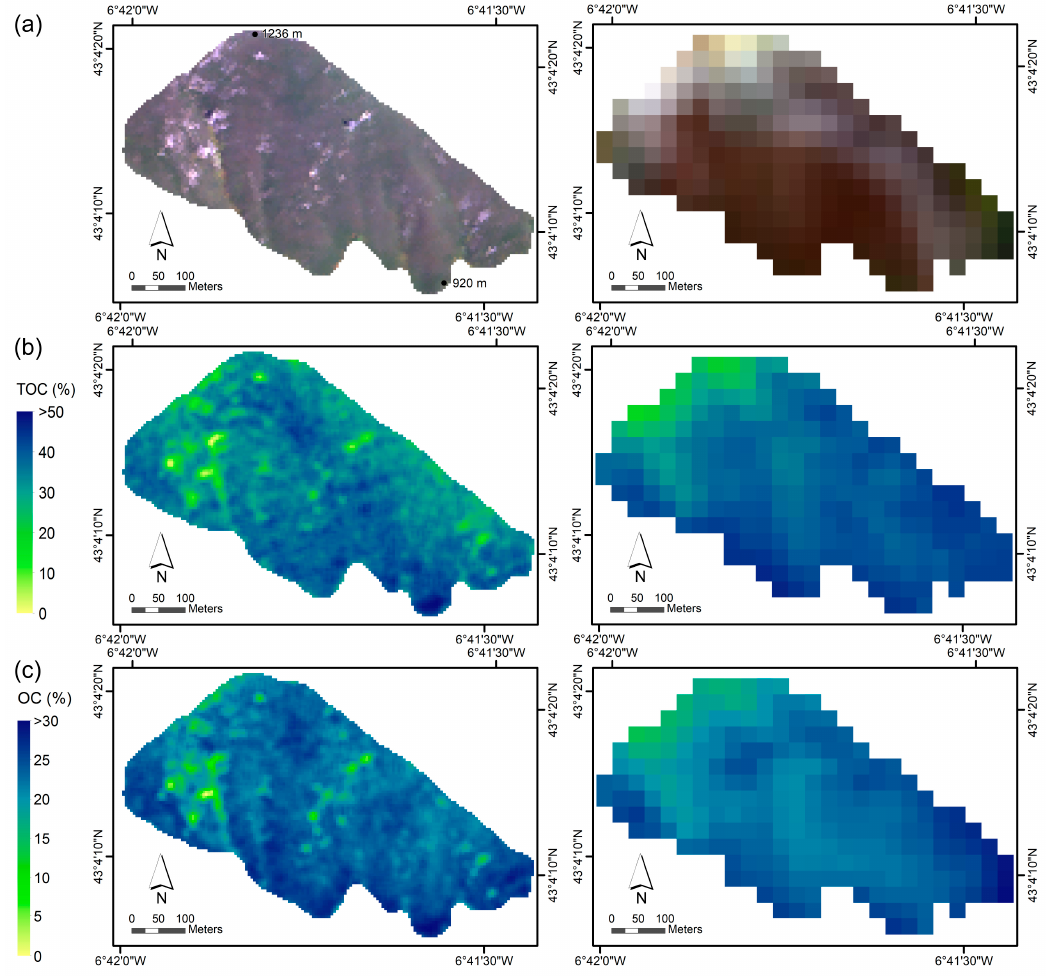
Figure 6. True-color composite ( a ) and maps of topsoil TOC ( b ) and OC content ( c ) predicted using the SMLR models based on spectral indices at the Combo site. Left: AHS image (airborne, spatial resolution of 5 m). Right: Hyperion image (satellite, spatial resolution of 30 m). The location of the Combo site is shown in Figure 1.